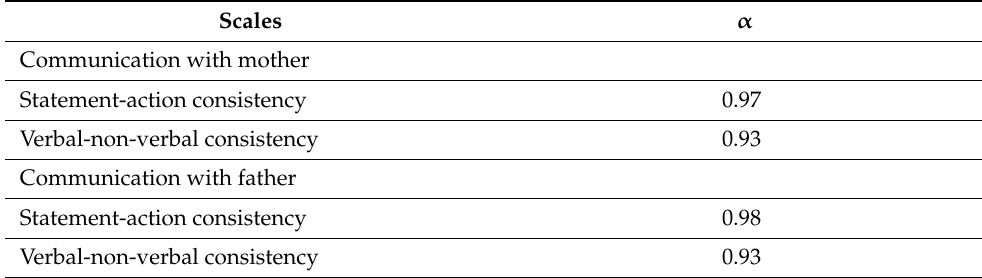
Table 5. Cronbach’s Alpha for scales of